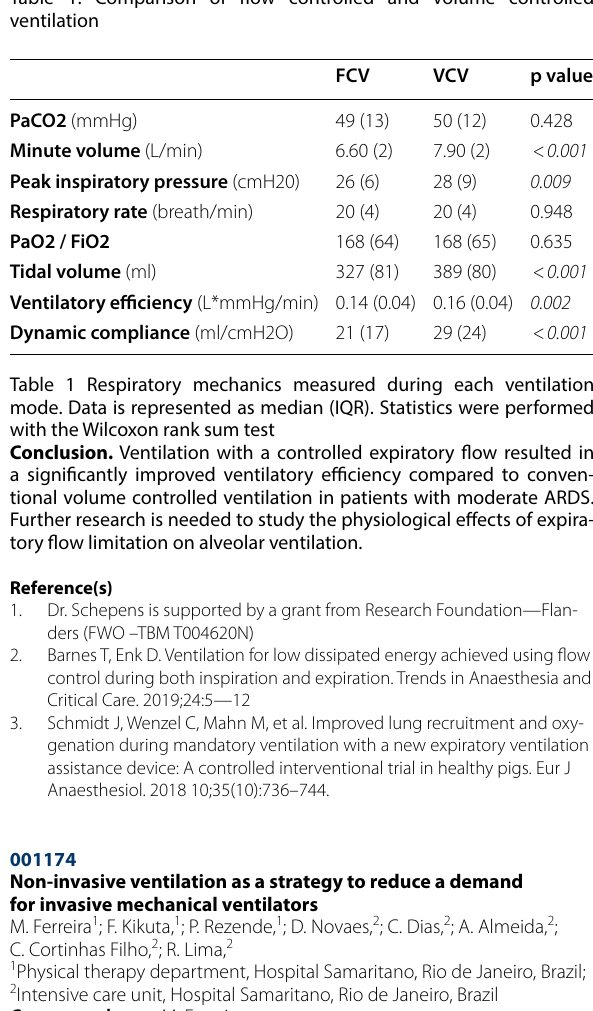
Table 1. Comparison of flow controlled and volume controlled ventilation